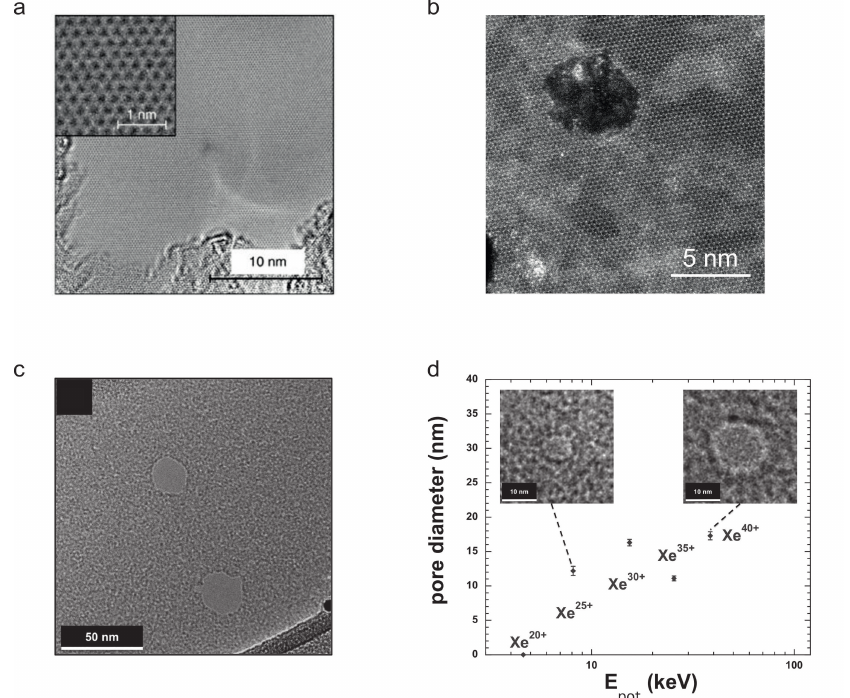
Figure 10. Examples for effects of HCI irradiation of 2D materials. ( a ) Graphene irradiated